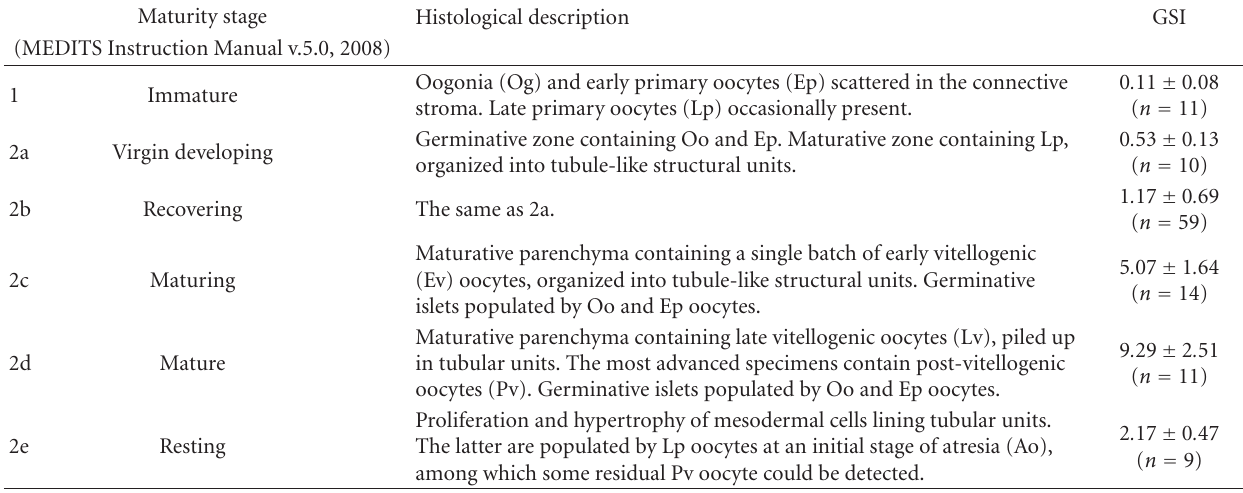
Table 4: Histological description of ovarian maturity stages in Aristaeomorpha foliacea , with their relative GSI (mean ±